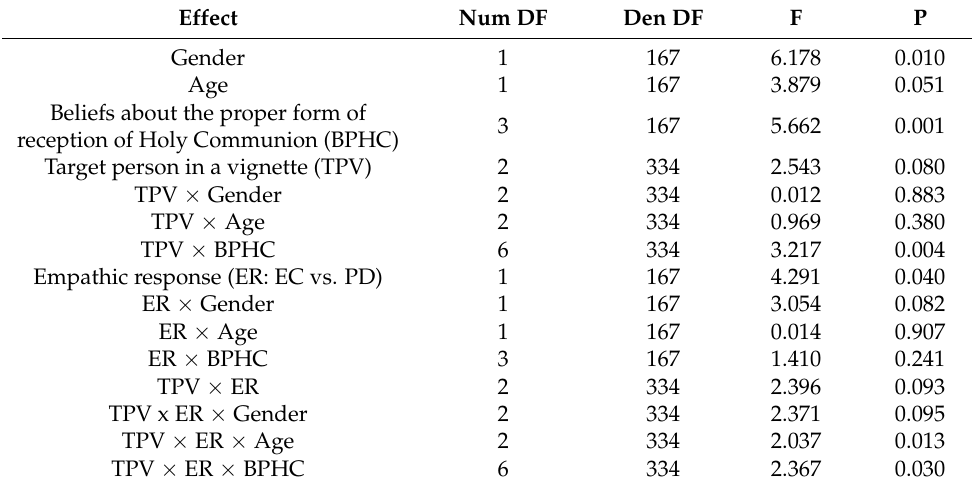
Table 3. The effects of belief group membership and target person predicting two forms of empathic responses (empathic concern and personal distress) controlled for